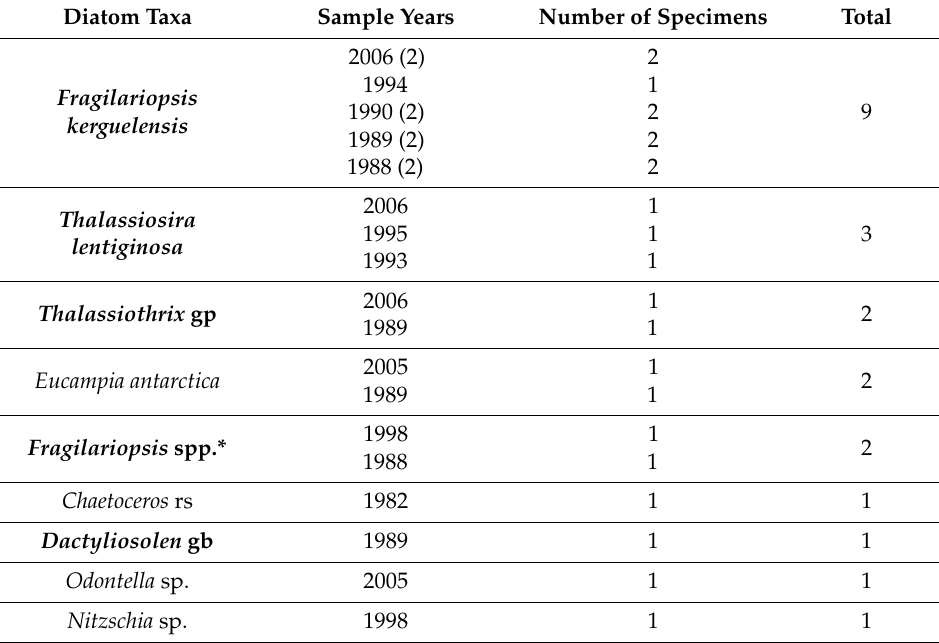
Table 1. Summary of diatom identifications.